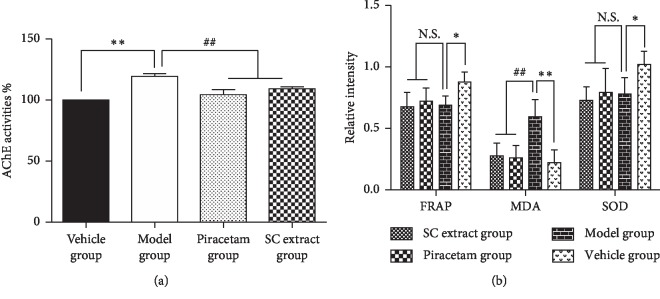
Effect of SC extract treatment on brain AChE and antioxidant enzymes activities (n = 10). (a) AChE; (b) FRAP, SOD, and MDA. Data are presented as mean ± SD. ∗p < 0.05 and p < 0.01vs vehicle group; #p < 0.05 and ##p < 0.01vs scopolamine model group.